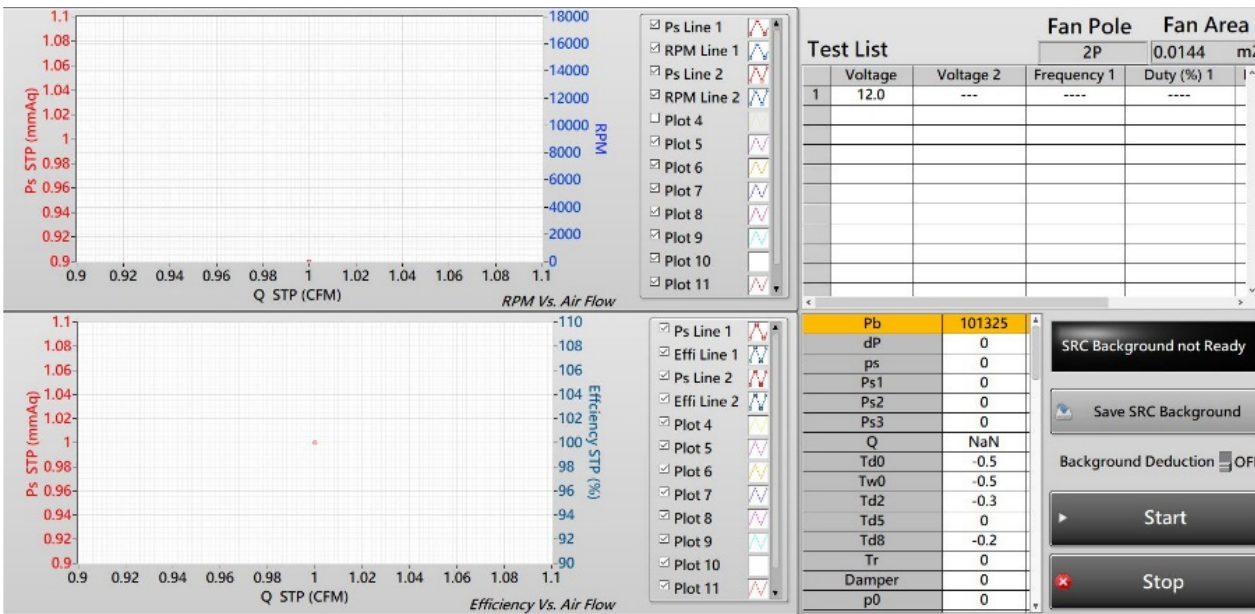
Figure 6. Schematic diagram of fan installation.